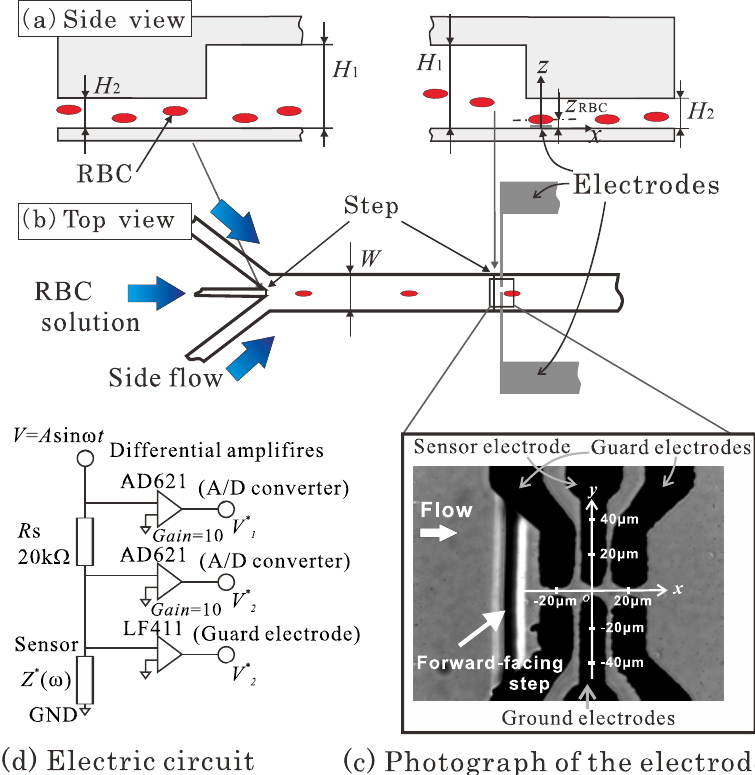
Figure 3. ( a ) and ( b ) schematics of the microchannel and electrodes of the sensor used in the experiment; ( c ) photograph of the electrodes used in the experiment; ( d ) schematic of the sensor electric